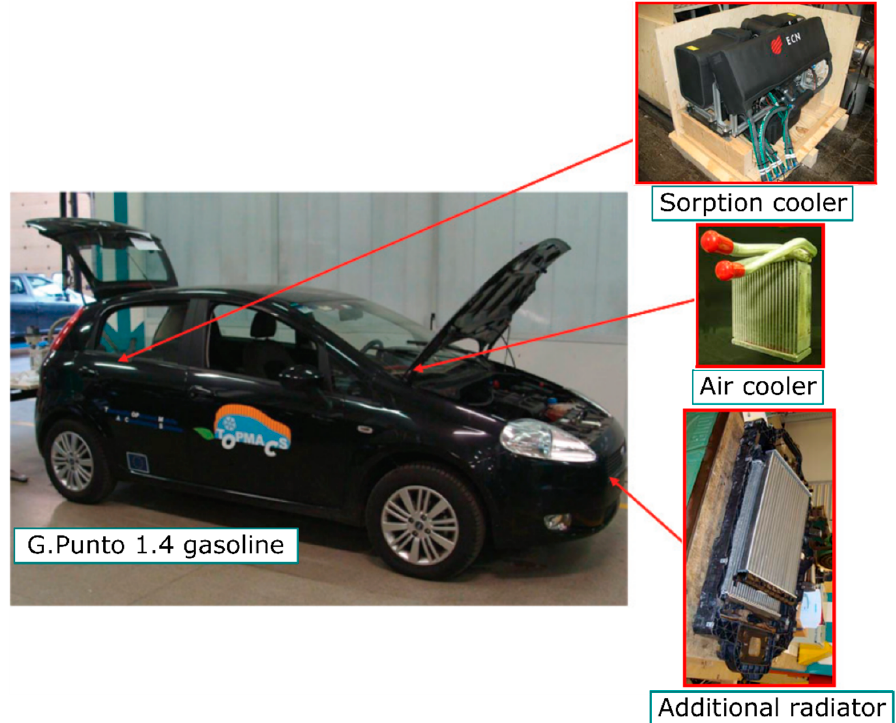
Figure 9. The pictorial view of the adsorption cooler and onboard test facility reported by Magnetto et al. [8].